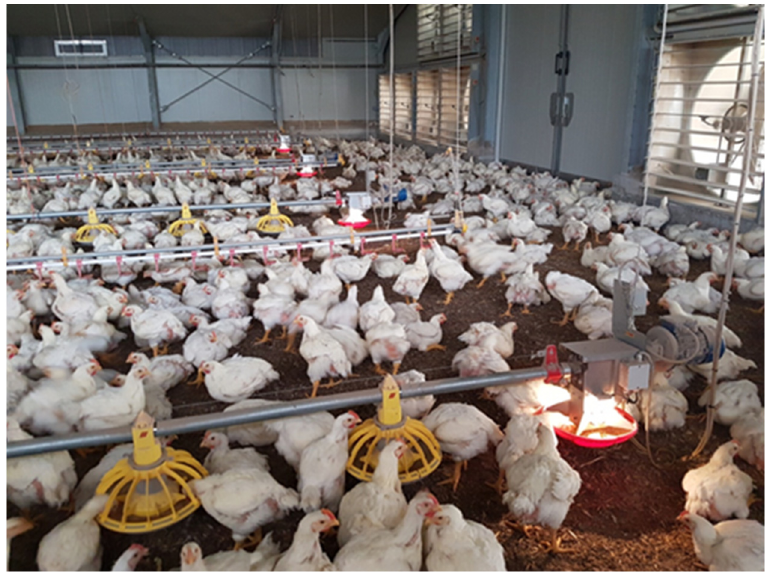
Figure 1. The feeder equipped with a LED light, applied at the end of each feeding line in F-LED. As concerns photoperiod, daily light was 24 h on day 0. Day length was reduced gradually (1 h per day) until reaching 18L:6D on day 7. As regards the light intensity, the recommended range of lux was provided at 30 lux until the end of the cycle. Environmental parameters (temperature, relative humidity) were regulated and monitored by means of a remote sensing system throughout the productive cycle. Each poultry house was divided into two pens by a 40-cm-high transversal net in order to house and rear males and females in separate areas.